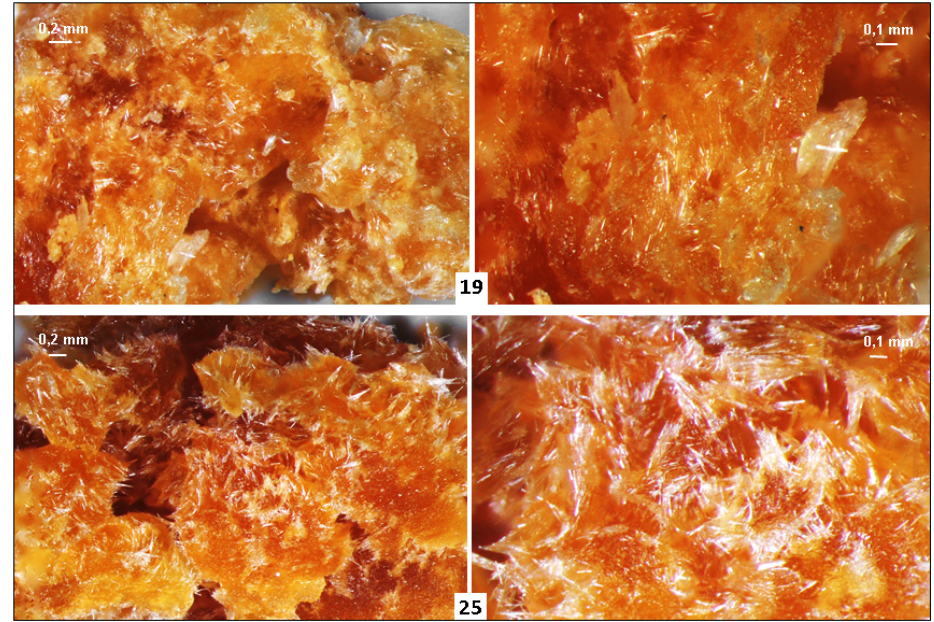
Figure 4. Stereomicroscope images of orange pickeringite (samples 19 and 25).